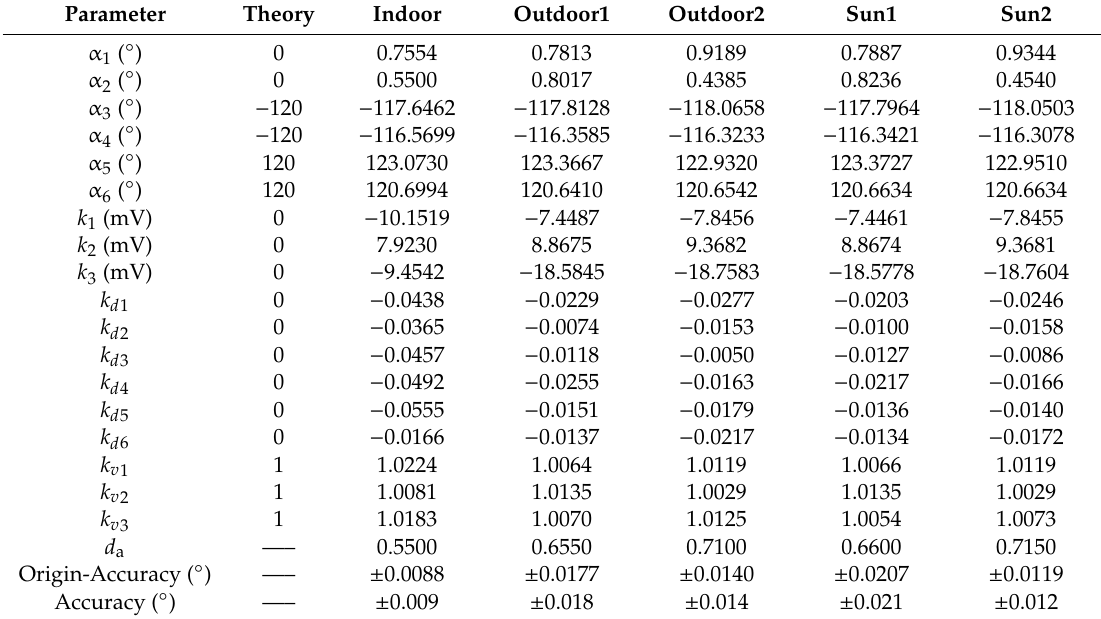
Table 2. Calibration parameters.